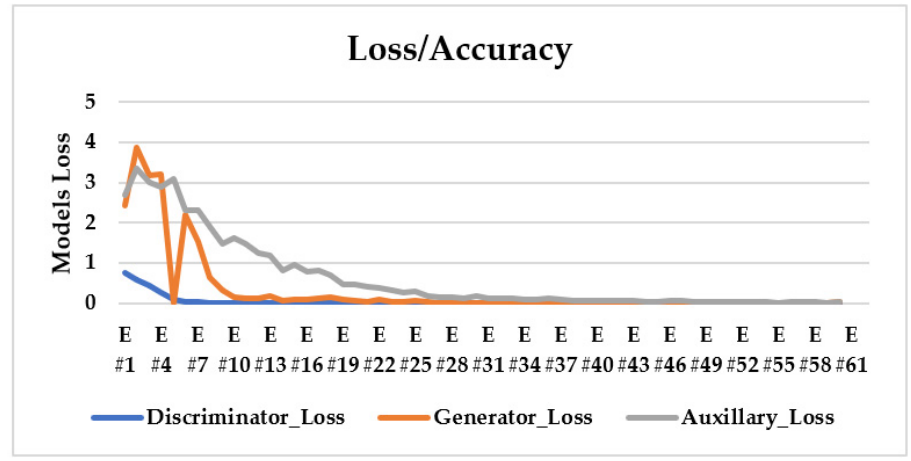
Figure 31. Loss/Accuracy curve for InfoGAN model training by TU Berlin dataset.